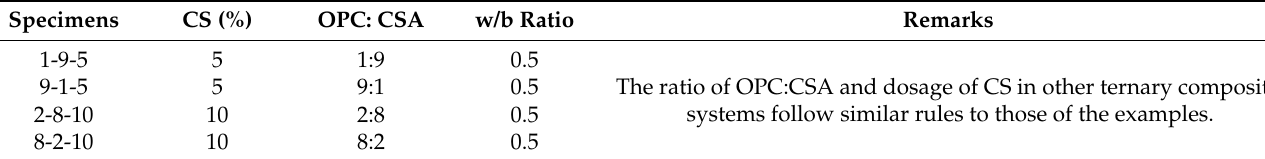
Figure 1. The particle size distributions of powder materials. Table 2. The mix proportions of different OPC-CSA-CS ternary composite systems.